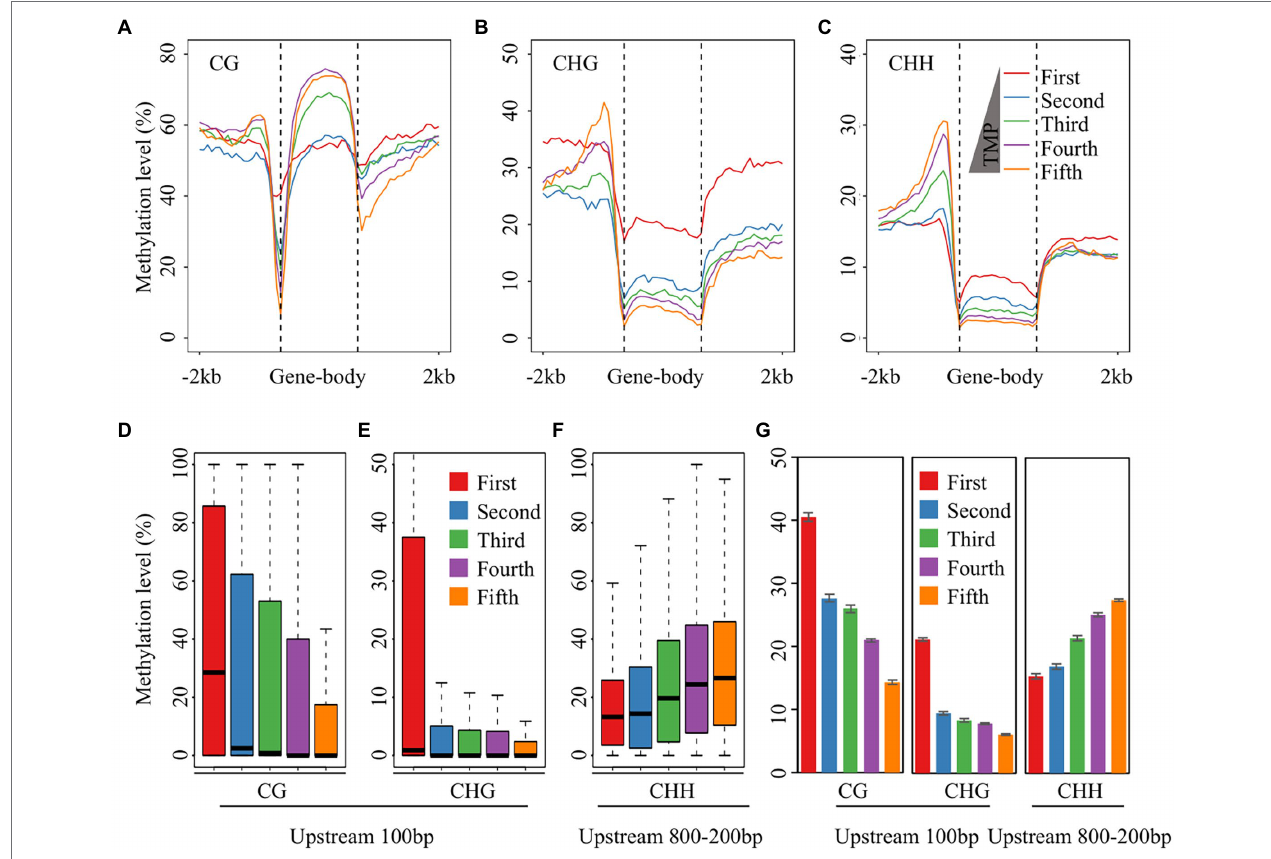
FIGURE 2 | Correlation analysis between gene expression and DNA methylation. (A–C) Comparative analysis between gene expression and DNA methylation for the CG (A) , CHG (B) , and CHH (C) sequence contexts. The expressed genes were equally divided in to four groups according to the expression value from low to high, except for the first group of genes whose expression value was 0. (D,E) The distribution of CG (D) and CHG (E) methylation levels of the 100 bp upstream of TSS. (F) The distribution of CHH methylation levels of 200–800 bp upstream of TSS. (G) The average CG and CHG methylation levels of the 100 bp upstream of TSS, and the average CHH methylation levels of the 200–800 bp upstream of TSS after five DON concentration